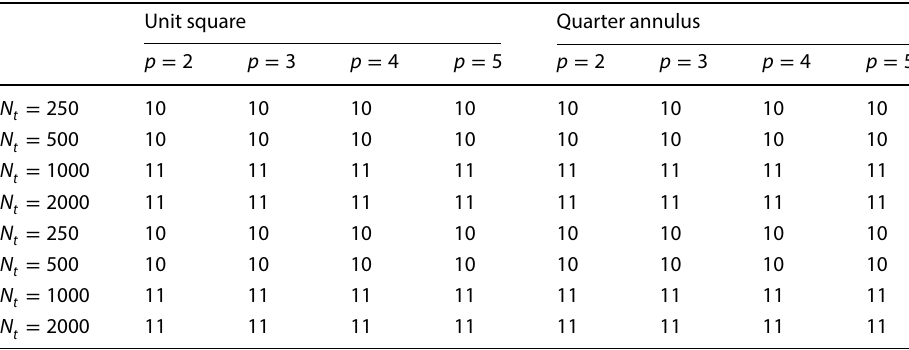
Here, p -multigrid (top) and the CG method (bottom) are adopted for the spatial solves and backward Euler for the time